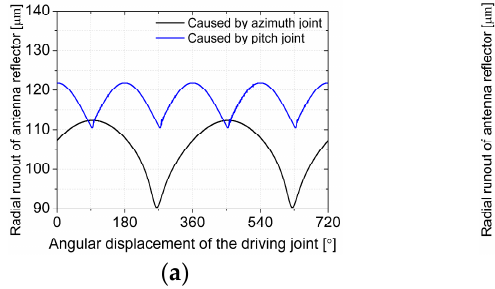
Figure 14. Radial runout of antenna reflector caused by different clearance size of planetary gear—the back solid line represents changing the clearance size in the azimuth joint; the blue dashed line represents changing the clearance size in the pitch joint; ( a ) c ip = 100 μ m, b isp = b irp = 100 μ m; ( b ) c ip = 100 μ m, b isp = b irp = 10 μ m; and ( c ) c ip = 10 μ m, b isp = b irp = 100 μ m ( i = p , a ).